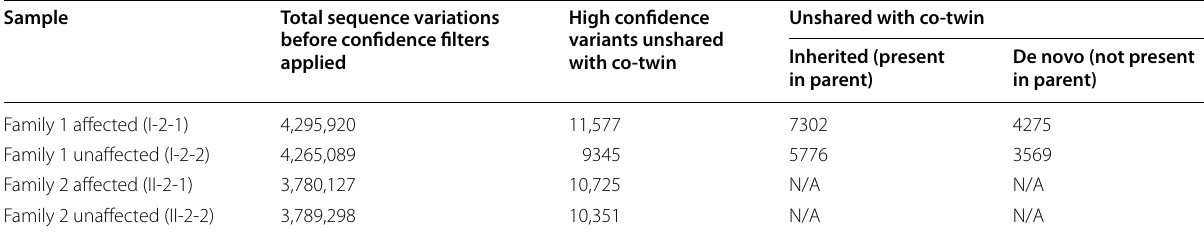
Table 2 Shared and de novo small sequence variations (SNVs, substitutions, Indels) as compared to NCBI Build 37